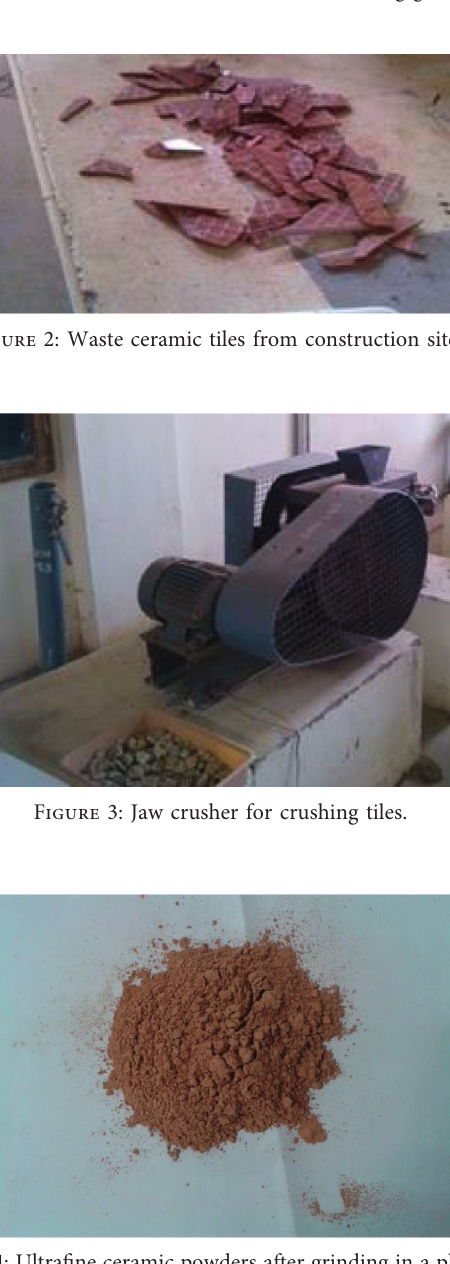
Figure 1: Zirconium balls and metakaolin during grinding.